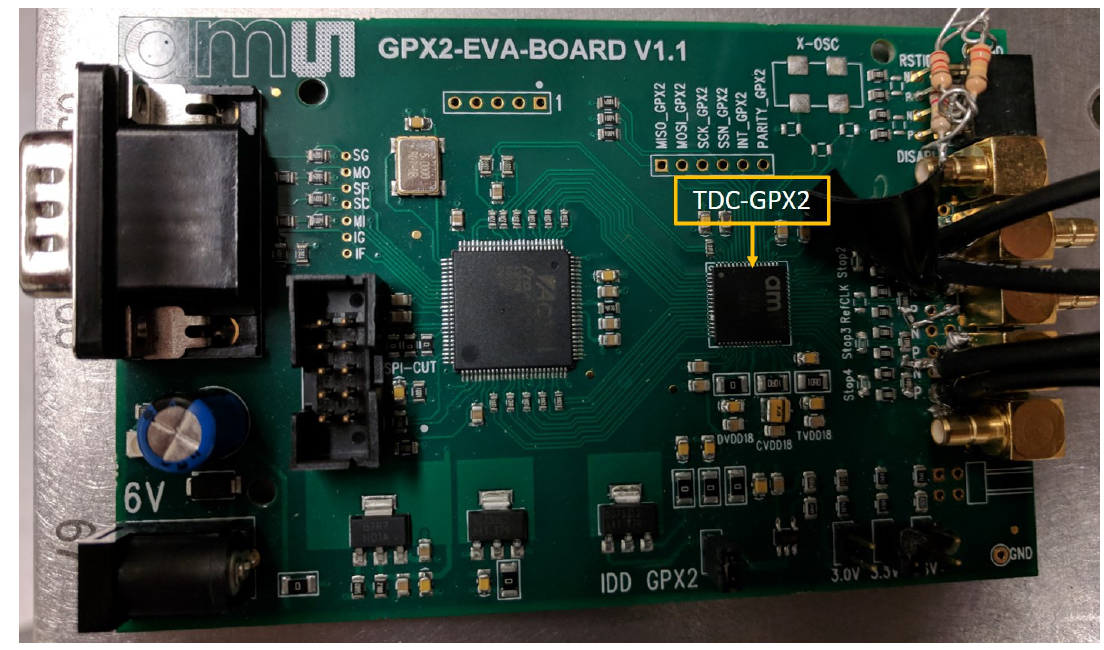
Figure 10. The TDC-GPX2 evaluation board used for laboratory testing of MOCT. The added SMA cables and resistors enable LVDS inputs for this development board.